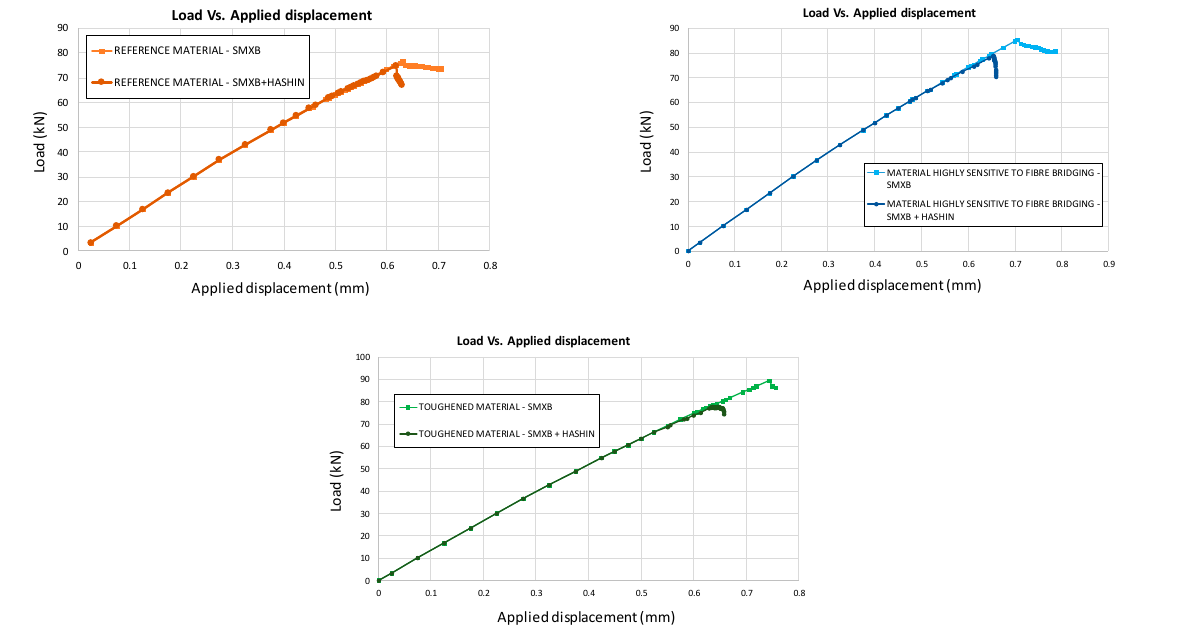
Figure 14. Load vs. Applied displacement comparison.